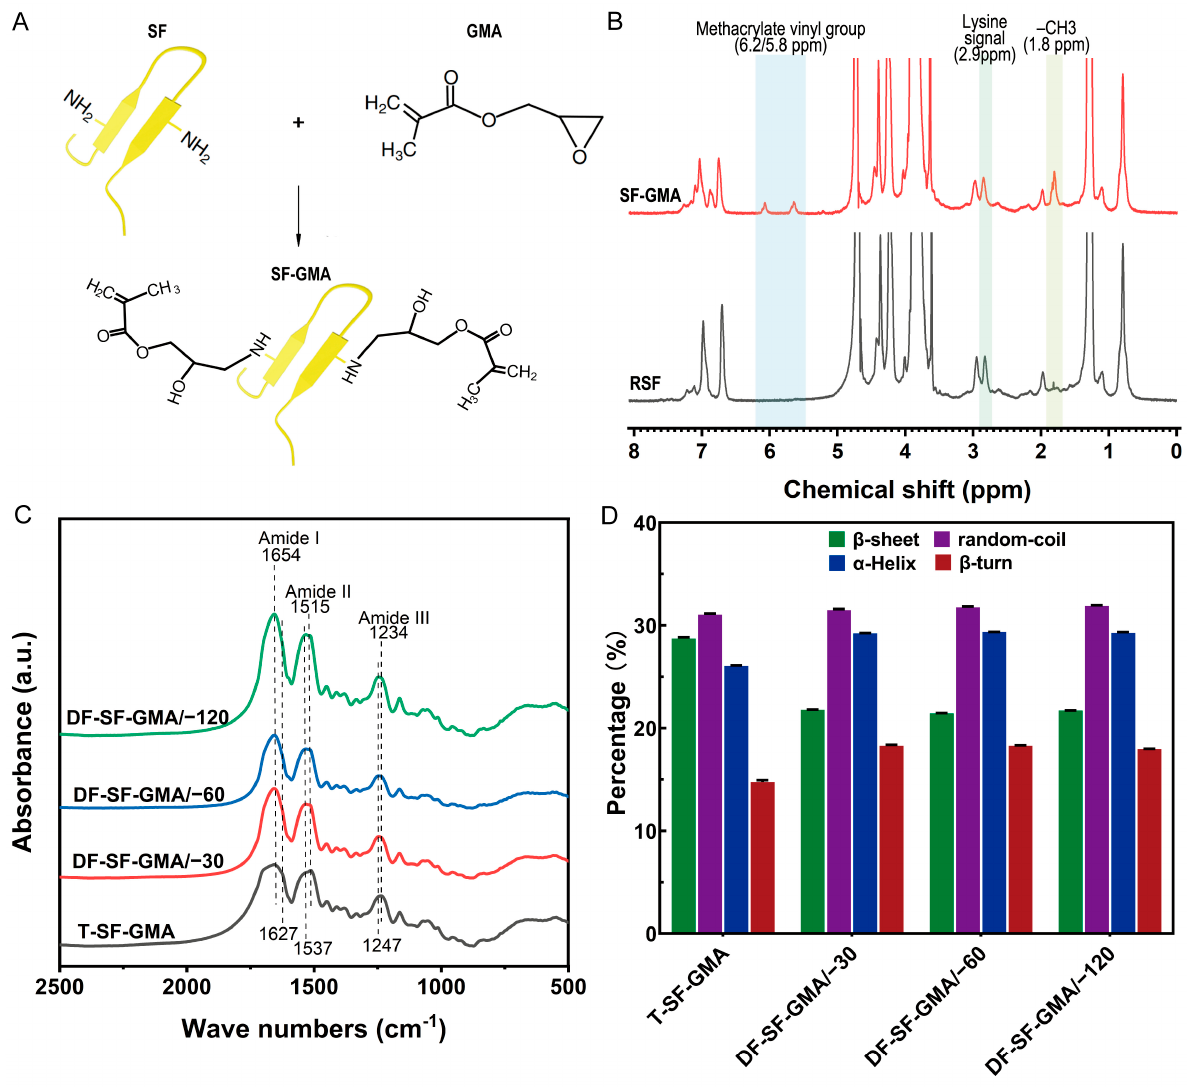
Figure 2. FTIR spectra and secondary structures of hydrogels. ( A ) Modification of SF molecule with GMA. SF was covalently grafted with GMA, which provides a vinyl double bond as a UV-crosslinking site. ( B ) 1 H-NMR spectra of the pristine RSF and the SF-GMA. The modification of lysine residues in SF with GMA was confirmed by the gradual decrease in the lysine signal and an increase in the methacrylate vinyl group and the methyl group signals. ( C ) FTIR spectra of the T-SF-GMA and DF-SF-GMA hydrogels. ( D ) Quantitative analysis of secondary structures in the T-SF-GMA and DF-SF-GMA hydrogels. Data are shown as mean ± S.D.; n = 3.